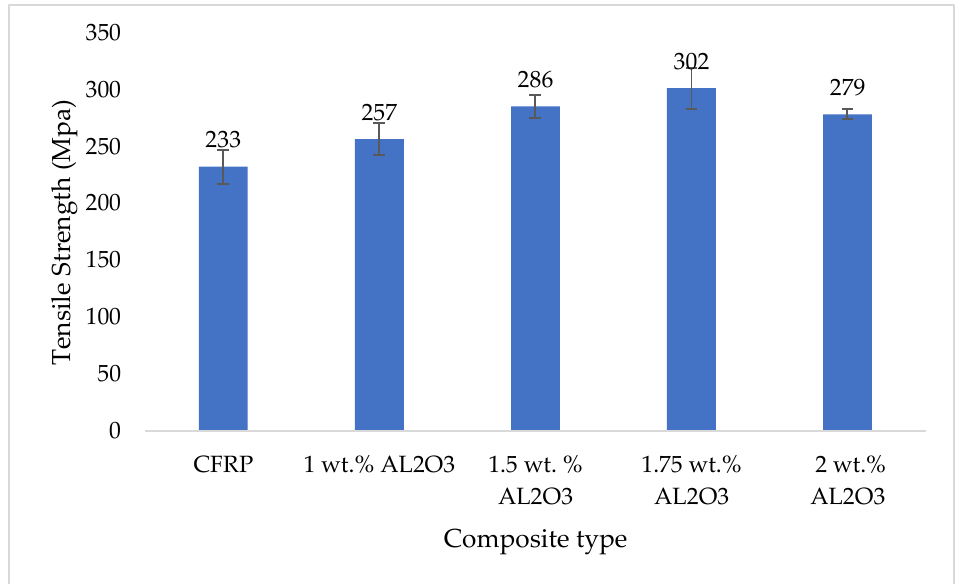
Figure 6 . Tensile strength of CFRP and hybrid Al 2 O 3 nano-composites.